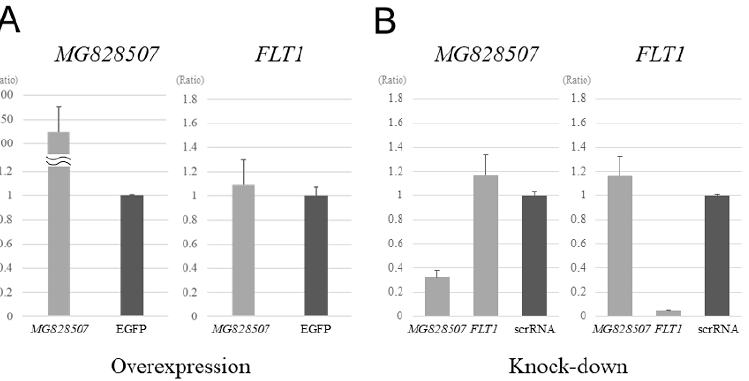
Figure 3. Analysis of the overexpression and knockdown of MG828507 . ( A ) Expression of MG828507 and FLT1 after the exogenous overexpression of MG828507 . HTR-8 trophoblast cells were transfected with an MG828507 expression vector. The MG828507 and FLT1 transcript levels were analyzed by qRT-PCR. The vertical axis indicates the ratio relative to the data of cells transfected with control vector. ( B ) Expression of MG828507 and FLT1 after the knockdown of MG828507 . HTR-8 trophoblast cells were transfected with an siRNA targeting MG828507 . The MG828507 and FLT1 transcript levels were again analyzed by qRT-PCR. The siRNA for FLT1 as well as a scrambled siRNA control were also used independently as control transfection experiments. The vertical axis indicates the ratio relative to the data of cells transfected with control